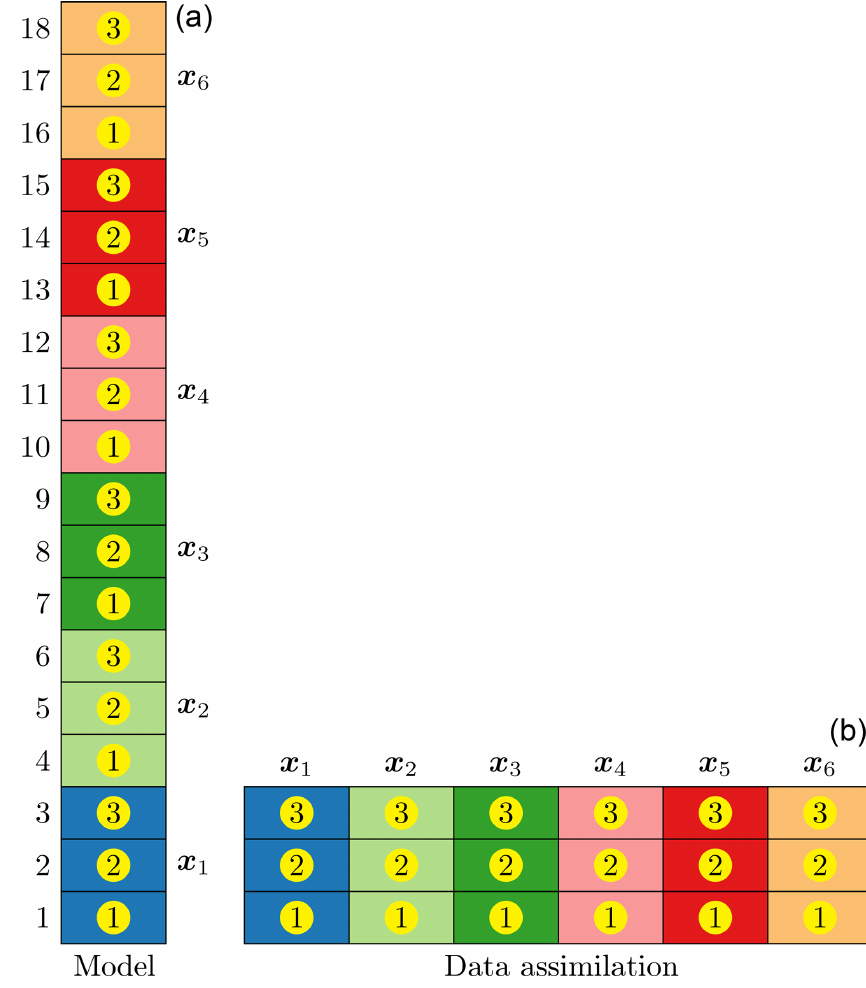
Figure 2. Schematic diagram illustrating the implementation of an online EnKF system. In this example, 18 MPI tasks are used to integrate 6 ensemble members with 3 MPI tasks per member; then the first three MPI tasks are used to perform the assimilation analysis. The numbers on the left of the model panel (a) are the ranks of the MPI tasks in the global MPI communicator. The grid cells with the same background colour in the model panel belong to one ensemble member x k . The numbers with a yellow circle, which demonstrate the parallel domain decomposition of the corresponding member, are the ranks of the MPI tasks in the model MPI communicator of the corresponding member. The data assimilation panel (b) demonstrates how the member state x k is assembled into the ensemble matrix X while keeping the same domain decomposition as the model members